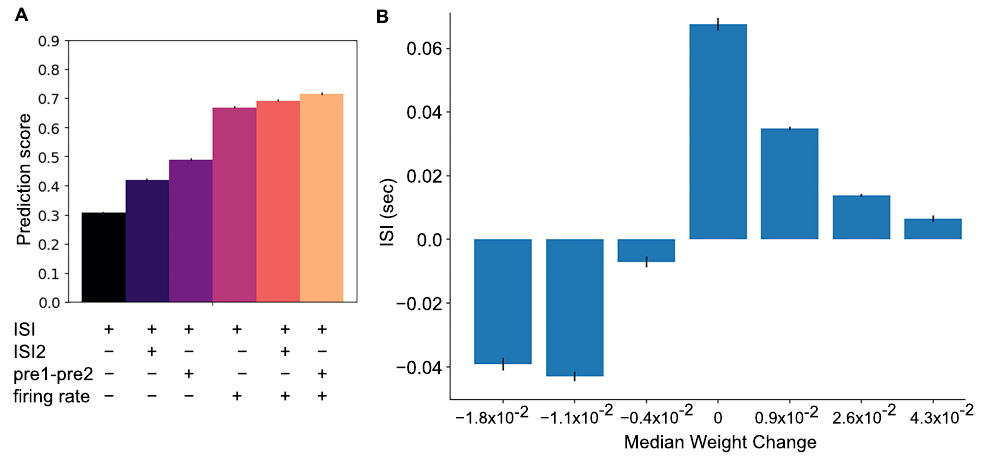
Figure 11. Both ISI and pre-synaptic firing rate are required to predict instantaneous synaptic weight change. Instantaneous weight change events were grouped into 7 weight change bins. Interspike interval was calculated from the closest pre-synaptic spike and closest post-synaptic spike that preceded the weight change event. ( A ) ISI and pre-synaptic firing rate together yielded the best two-variable prediction score. Adding in the interval between the two pre-synaptic spikes (pre1-pre2) produced a prediction score comparable to, but not better than the end weight prediction score. Note that a subset of instantaneous weight changes were not preceded by two pre-synaptic spikes and thus were excluded from those random forest regressions. ( B ) The mean ISI was calculated for each weight change bin. Note that the highest weight increase had small positive interspike intervals, and smaller weight increases had larger postive interspike intervals. As predicted by STDP theory, the weight decreases had negative interspike